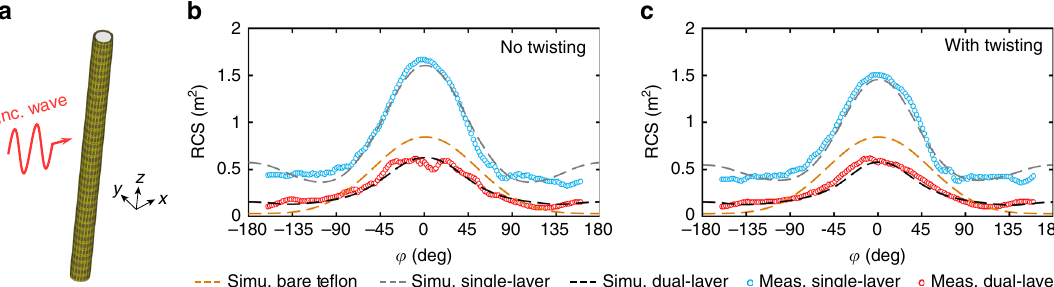
Fig. 4 Scattering properties of the sub-wavelength dielectric waveguide with metasurface coatings. a Con fi guration of the fi nite-length coated Te fl on rod waveguide excited by a TM polarized plane wave propagating in the + x direction. The simulated and measured RCS patterns in the x - y plane at the optimal frequency for the coated Te fl on rod waveguide b without and c with twisting perturbation on the inner